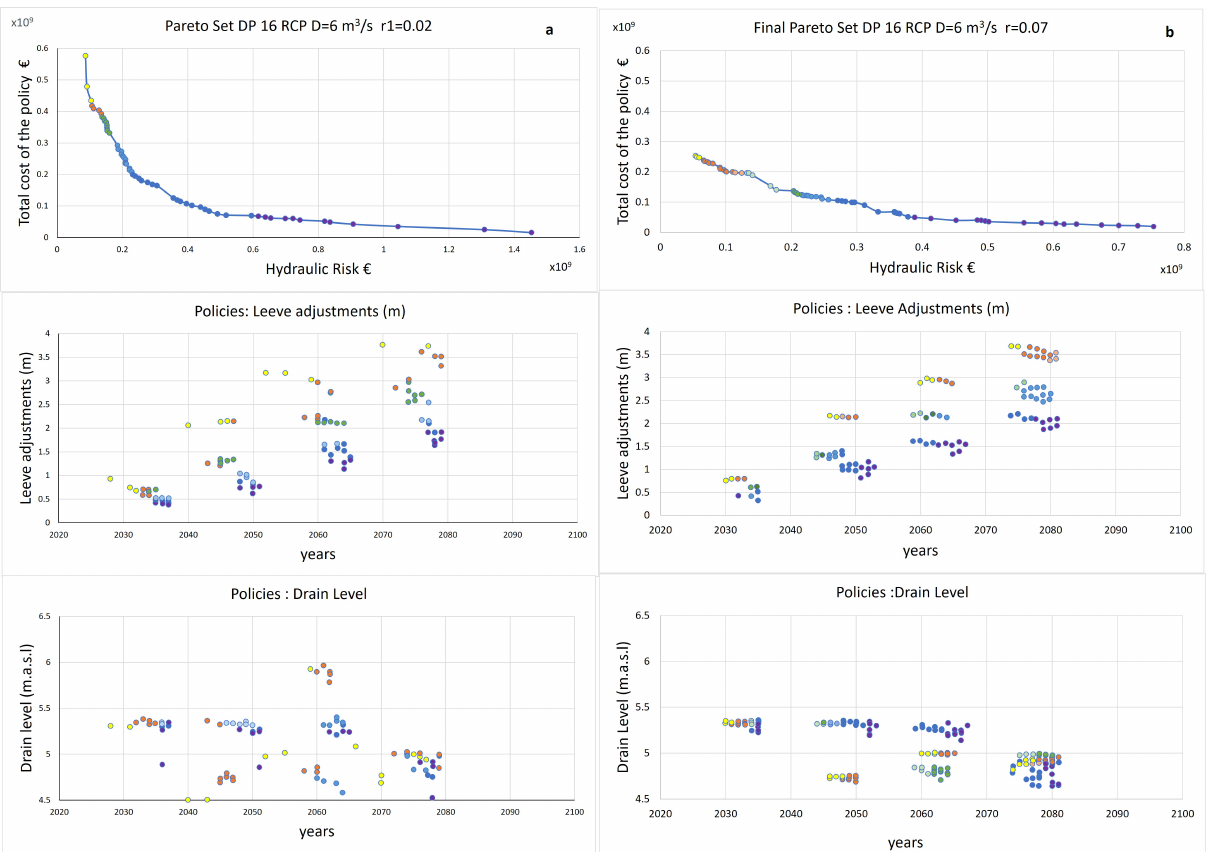
Figure 17. ( a , b ) Size and timing of Flood defence constructions for the Pareto set optimal solutions referred to scenario 4 of Table